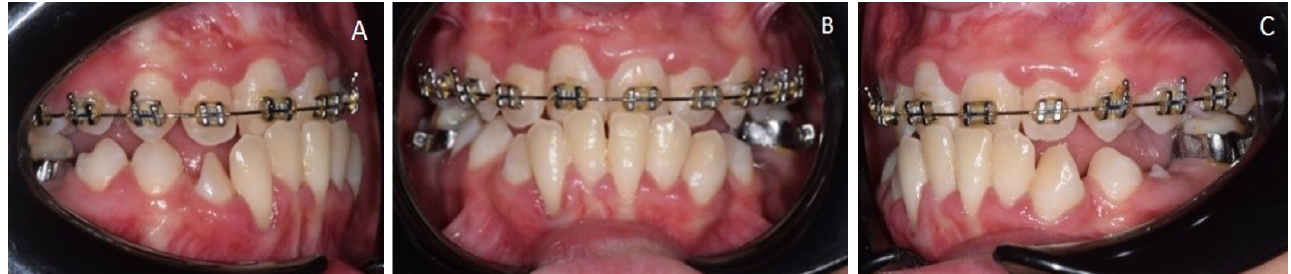
Figure 6. ( A) Right occlusion, ( B ), front occlusion ( C ), left occlusion.